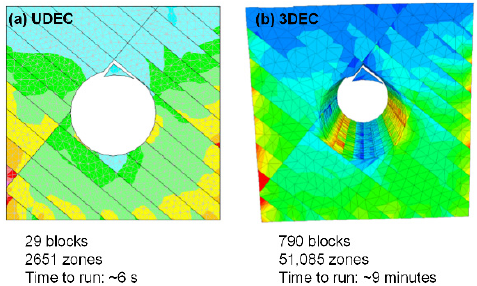
Figure 3. An example about the comparison of the run time between UDEC and 3DEC [44].